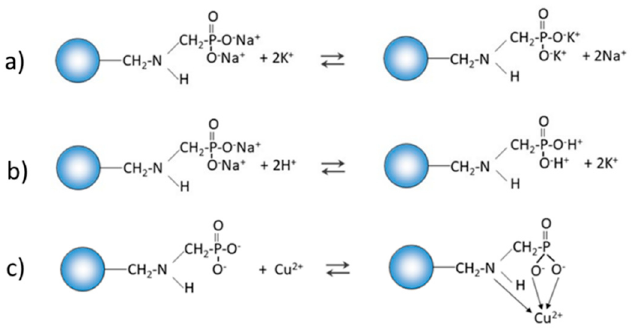
Figure 13. Mechanism of electrostatic interactions in ion exchangers with an aminophosphonic functional group.